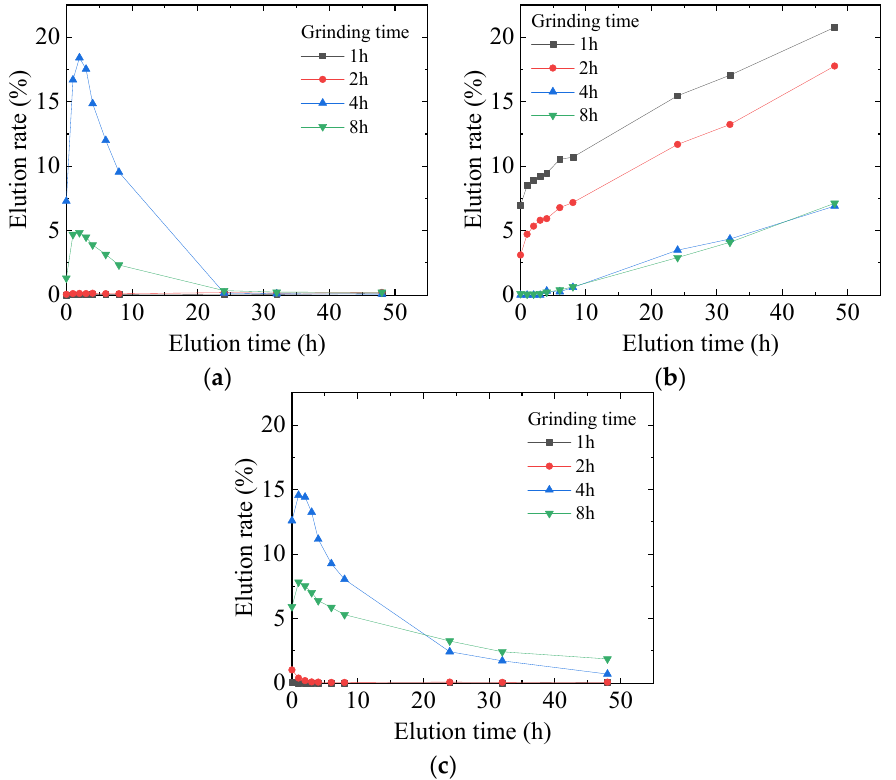
Figure 2. Elution rate of ( a ) As, ( b ) Cu and ( c ) Fe from dry ground samples at different grinding times.